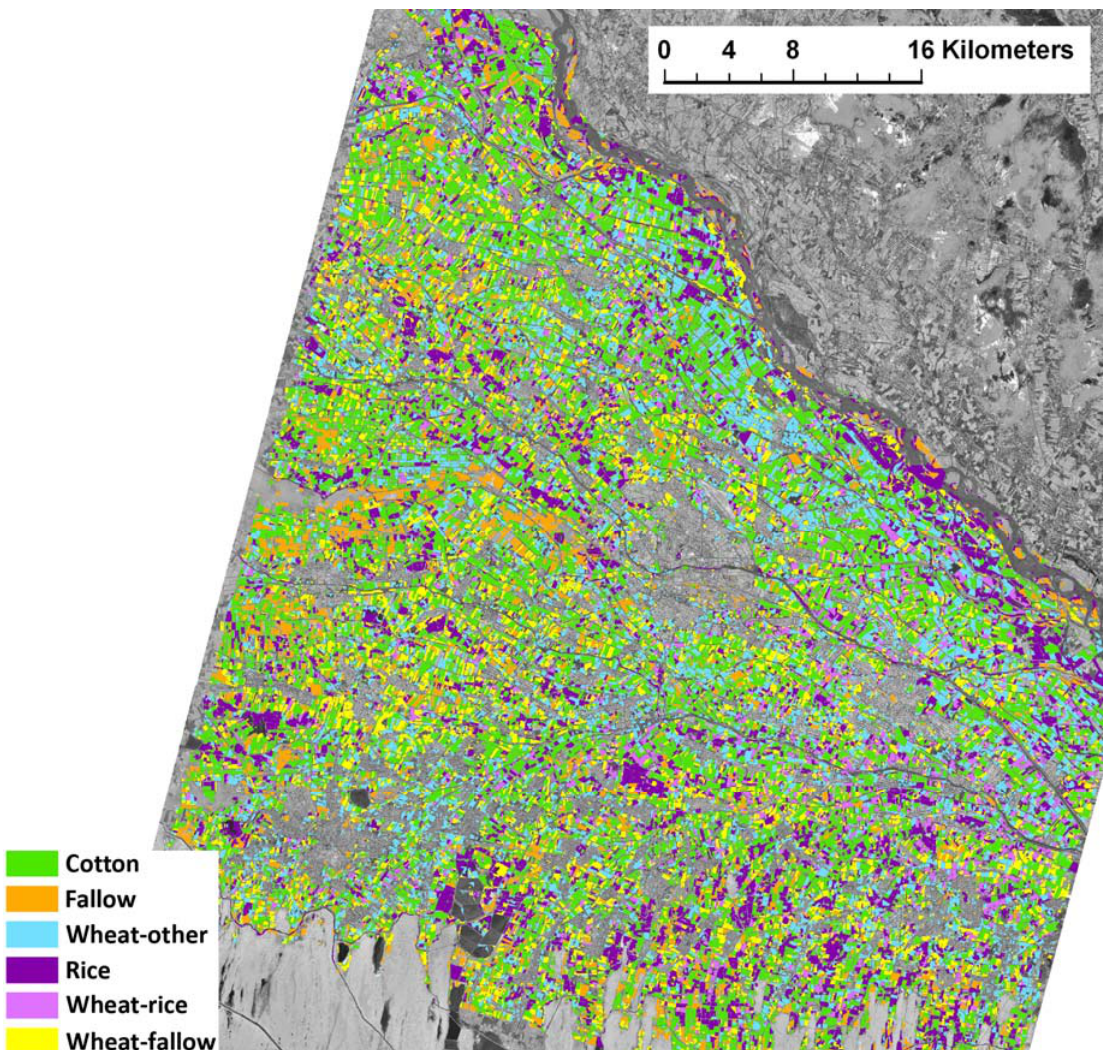
Figure 10. Map showing the per-field crop distribution over the entire study area derived from bi-temporal ASTER data recorded in 2007.